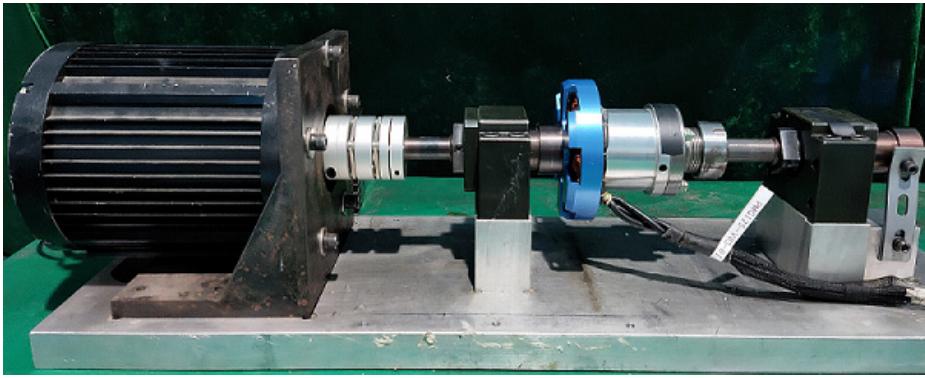
Figure 3. Generator testing bench .